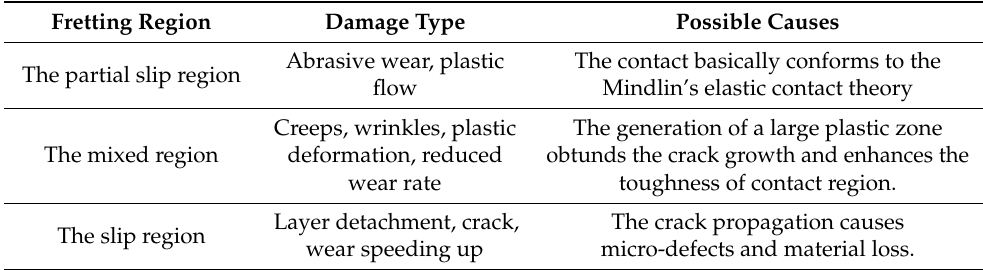
Table 2. Damage type and the causes for fretting